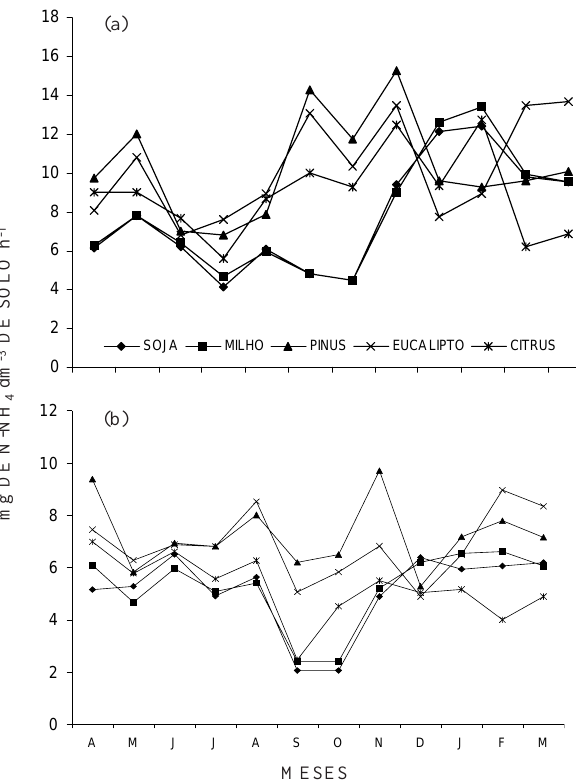
Figura 1. Velocidade de hidrólise da uréia (mg de N-NH 4+ dm -3 solo h -1 ) em amostras de LVaf (a) e LVd (b) cultivadas com soja, milho, pinus, eucalipto e citrus, em função do tempo de amostragem.